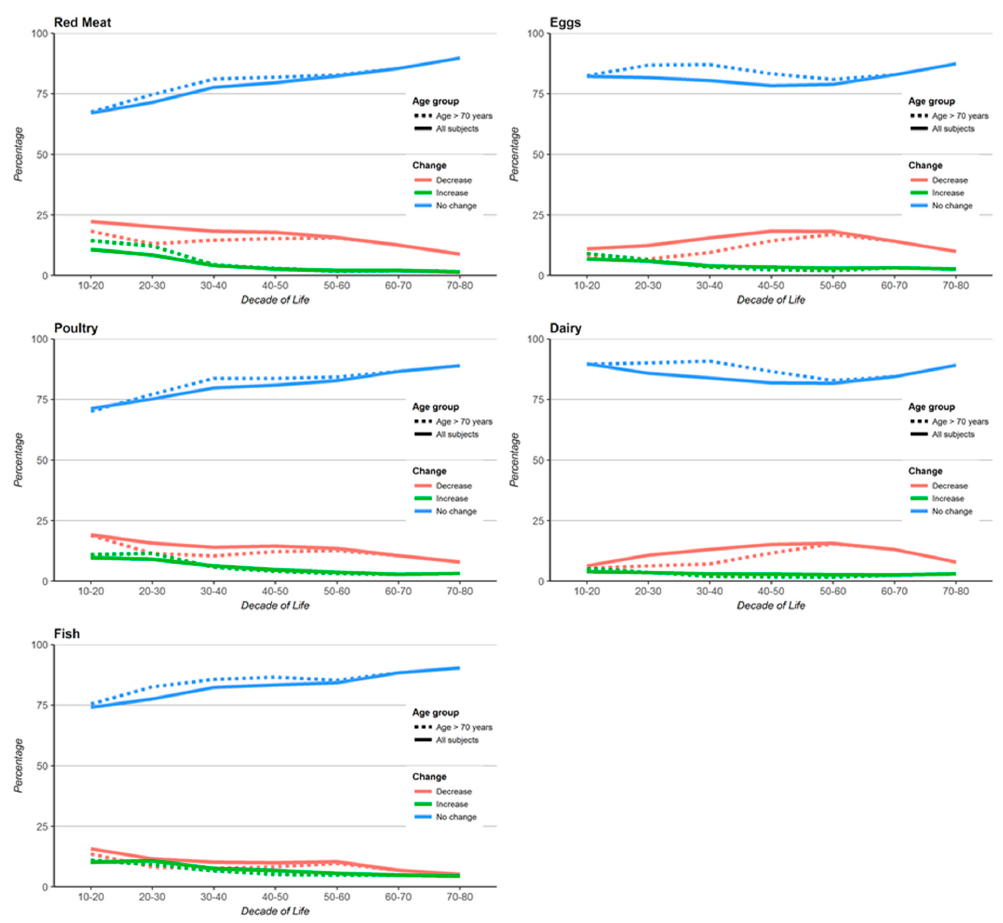
Figure 2. Distribution of changes (increase, decrease, no change) of consumption of animal products from one decade of life to the following decade. Dotted lines represent a sub-cohort of the oldest individuals with age ≥ 70 years ( N = 15,332). Adjusted for gender and race.